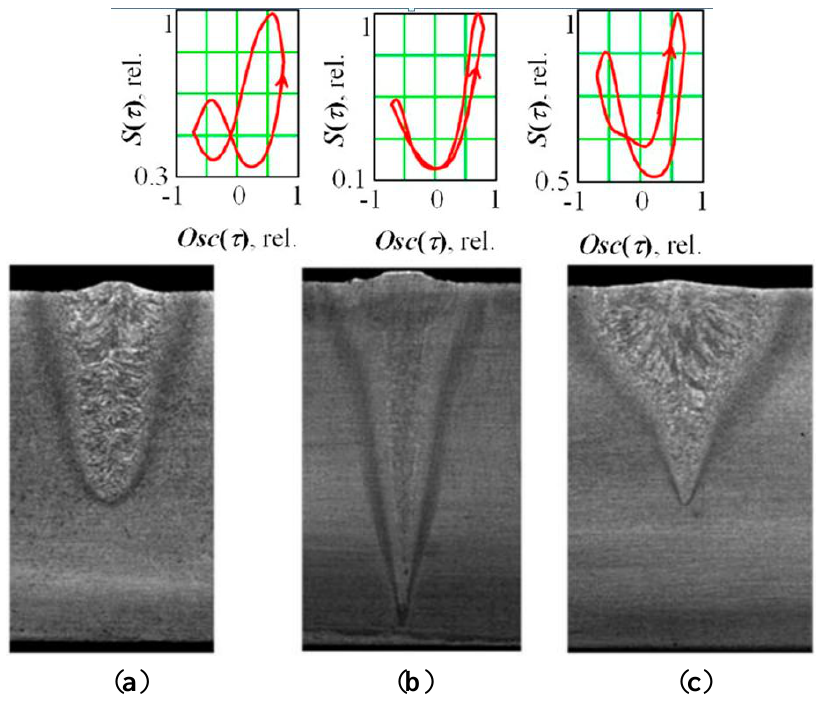
Figure 7. Results of coherent accumulation at the steel welding with oscillation along the joint for different focus regime. ( a ) underfocused (  I (  I = 0); ( c ) overfocused regimes (  I f f = 645 Hz, sweep size 2A = 1.5